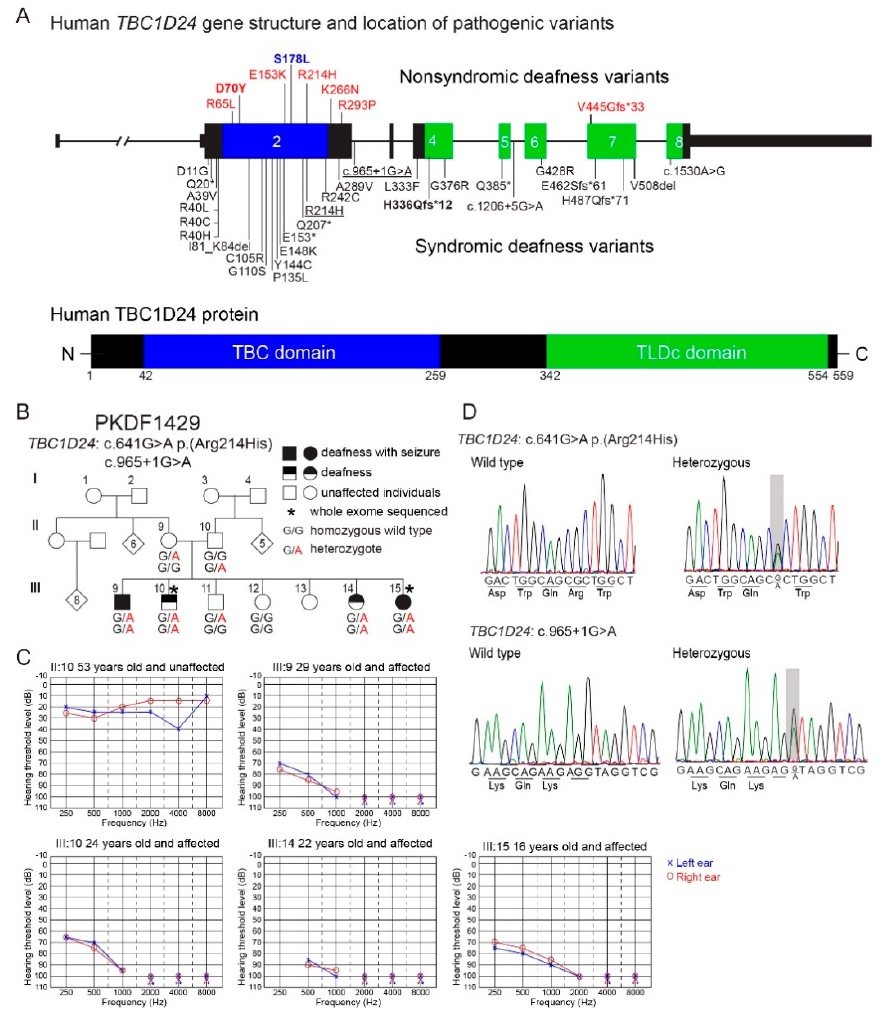
Figure 1. ( A ) A diagram of the human TBC1D24 gene displaying the approximate locations of pathogenic variants associated with non-syndromic deafness and syndromic forms of deafness. The eight annotated exons of human TBC1D24 encode a TBC domain (blue) and a TLDc domain (green). Eight reported pathogenic variants associated with non-syndromic deafness are drawn above the gene structure. p.Ser178Leu (blue) is an autosomal dominant variant associated with progressive deafness DFNA65 reported to be segregating in two unrelated families [11,12]. Other non-syndromic variants (red font) are associated with DFNB86 recessively inherited deafness. Twenty-eight